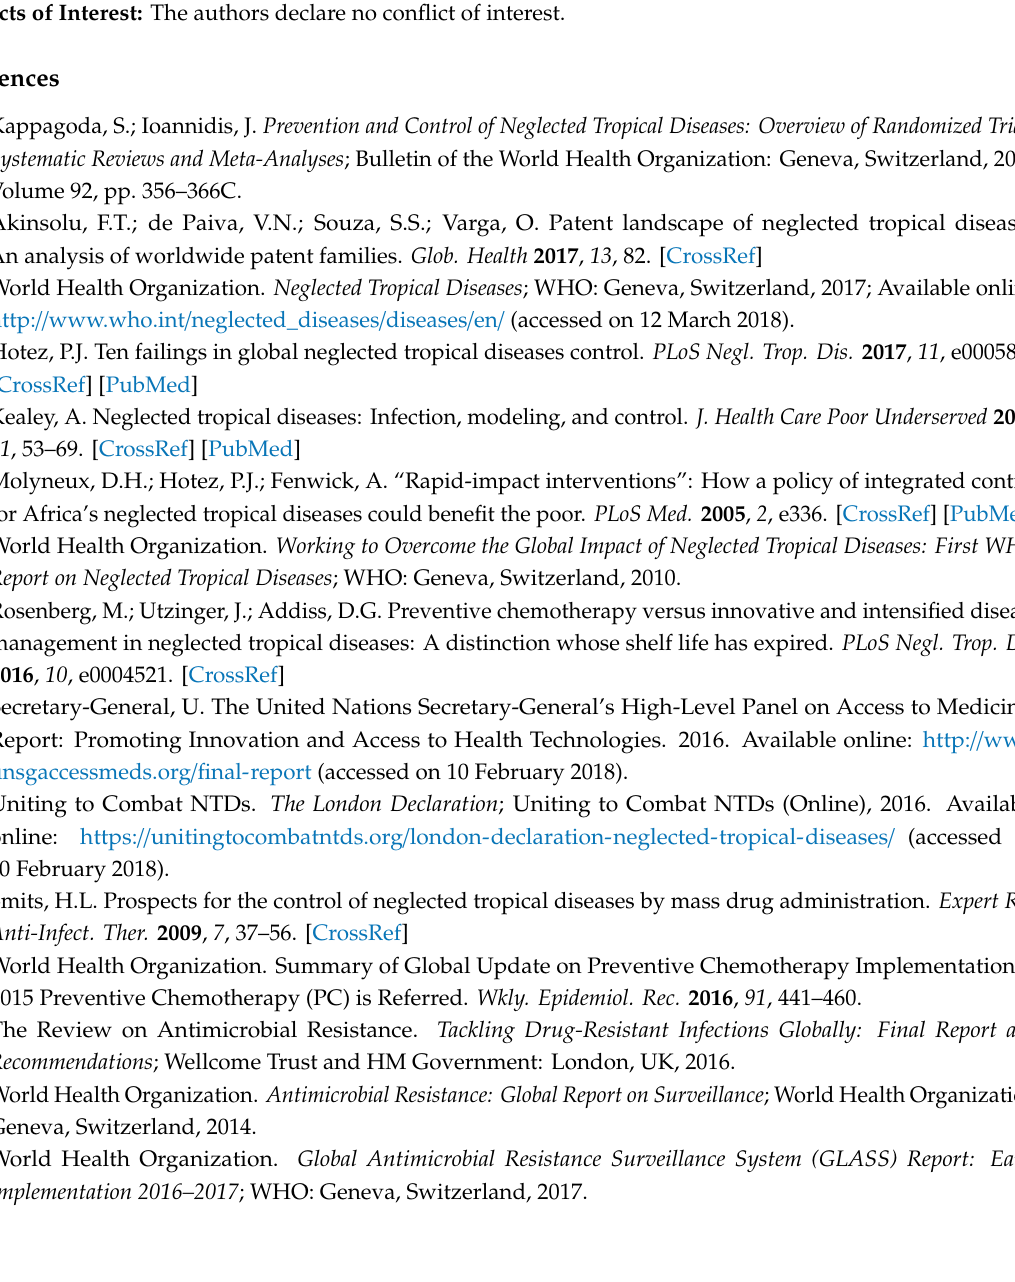
Table S1: PRISMA Checklist; Table S2: NTDs search terms and search strategy; Table S3: Quality assessment